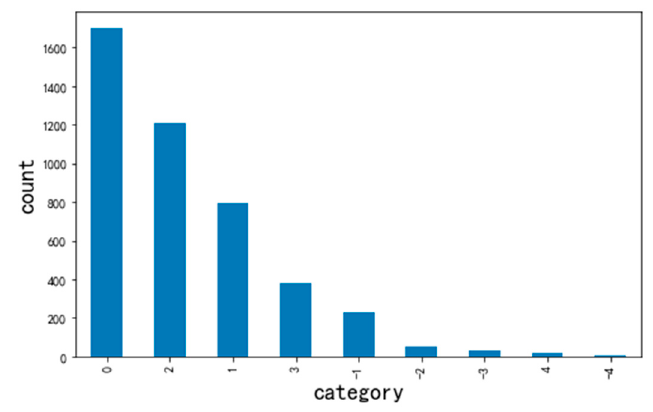
Figure 9. The sentiment distribution of the review text of Tower of London.